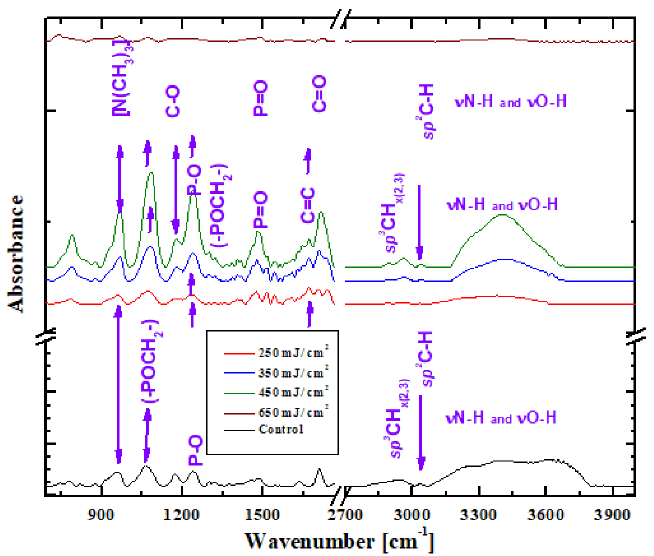
Figure 5. FTIR spectra of pMPC coatings obtained by MAPLE on Si as compared to the initial material.